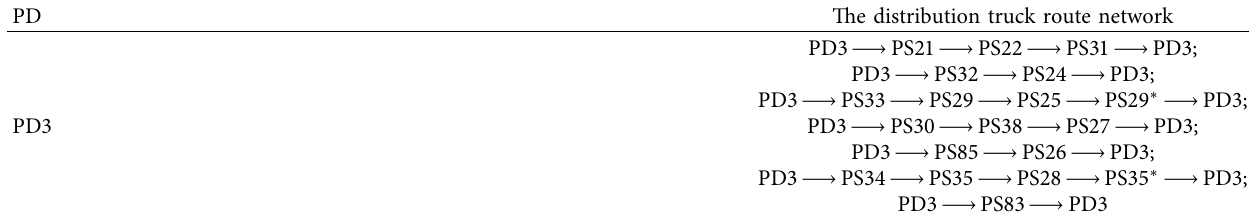
Figure 9: Comparison between initial and optimized networks k 3 usage solutions. Table 11: Distribution truck route arrangements of PD3 after optimization.